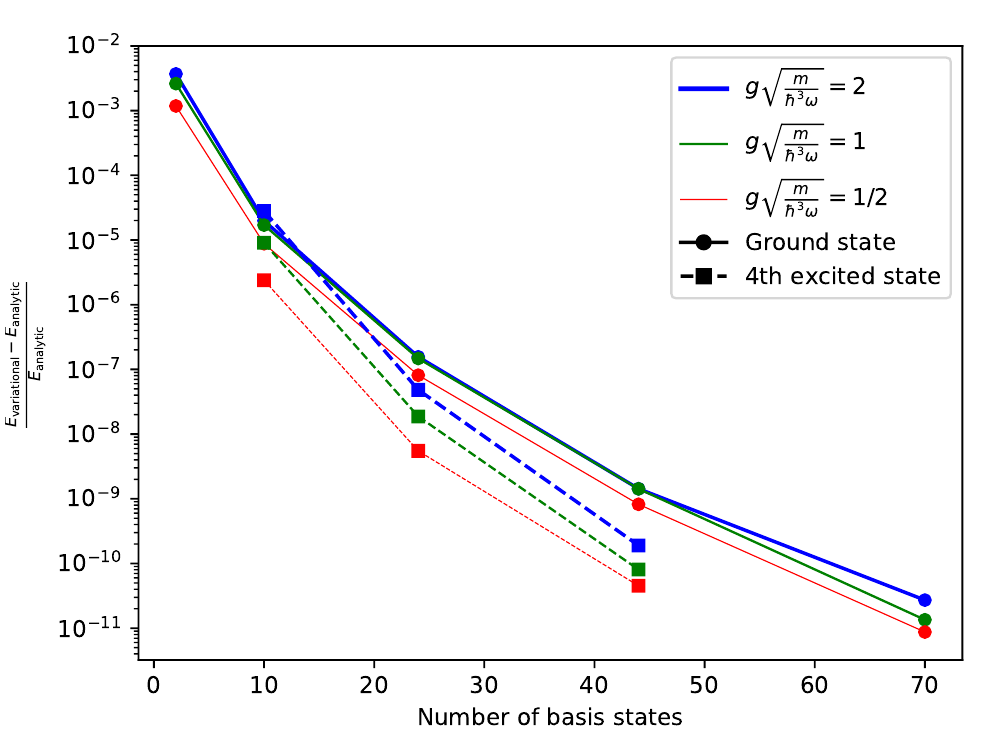
Figure 3: Convergence of the energies in the 1 + 1 system in a harmonic trap, com- paring the variational method to the analytical